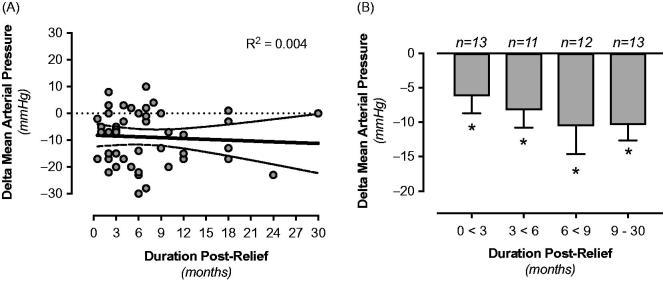
Impact of the length of the follow-up period before reassessing blood pressure after surgery. Linear regression analysis did not show any significant correlation between the length of the postoperative period and the change in arterial pressure (A). Significant reduction of blood pressure was observed in all groups compared with pre-relief values, independent of the length of the duration of the post-relief period, i.e. 0 to <3, 3 to <6, 6 to <9, and 9–30 months (B). No differences were observed among the different groups. *p < 0.05 compared with pre-relief; n = number of patients in each group.